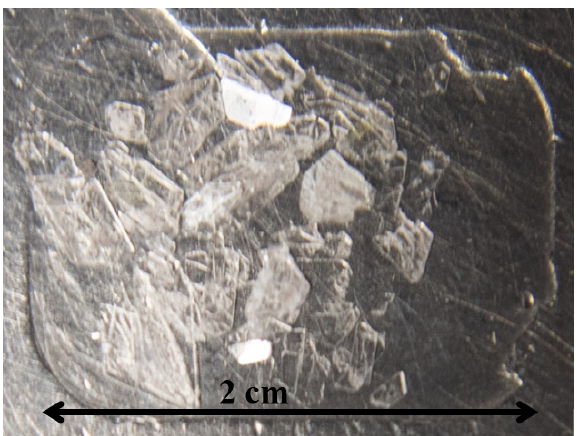
Figure 1. Optical microscopy image showing representative crystals of Rb 4 Ge 5 O 9 F 6 :Nb.